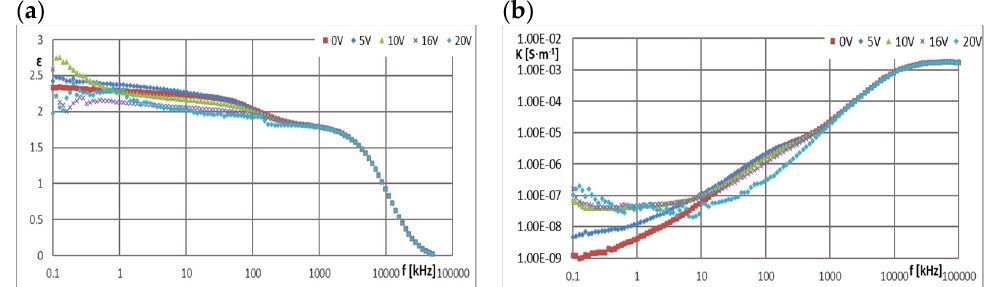
Figure 11. Characteristics: ( a ) ε = f( f ) and ( b ) κ = f( f ) for LID 3354S at different values of U.